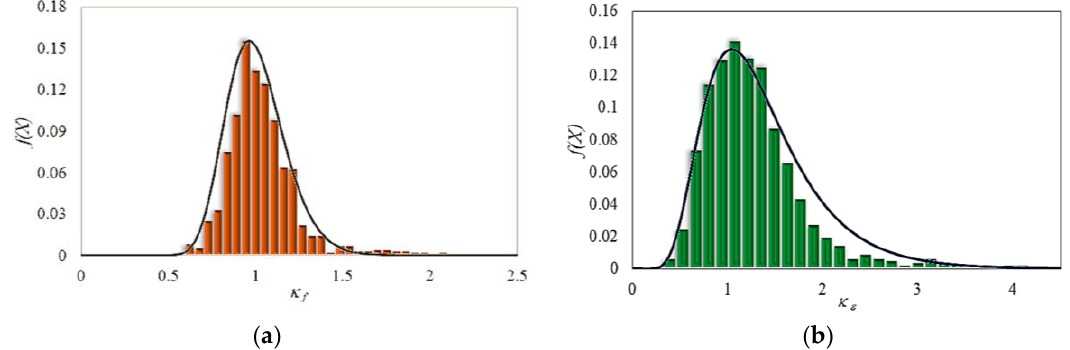
Figure 7. Chi-squared statistics of different distribution functions for model errors in the prediction of ( a ) strength and ( b ) strain enhancement ratio.